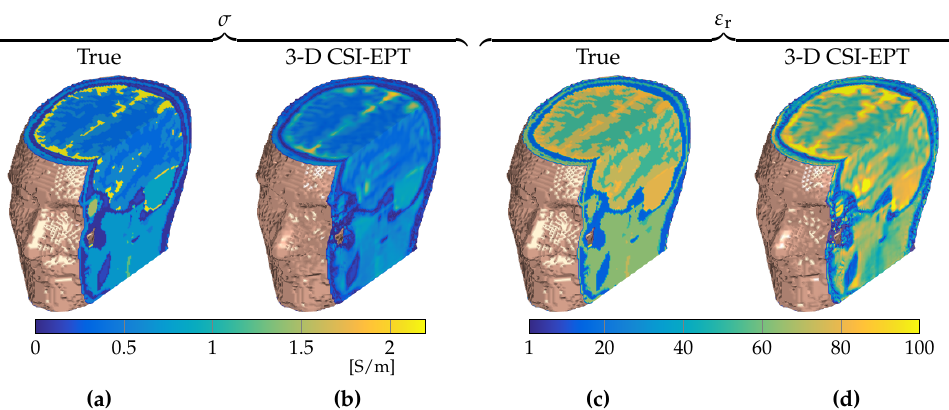
Figure 9. Three-dimensional visualization of a section of the 3D CSI–EPT reconstruction of the heterogeneous Duke head model (Figure 1b) after 50,000 iterations. ( a , b ) True and reconstructed conductivity, and ( c , d ) true and reconstructed relative permittivity. Top slice that is visible is the slice 5 cm above the transverse